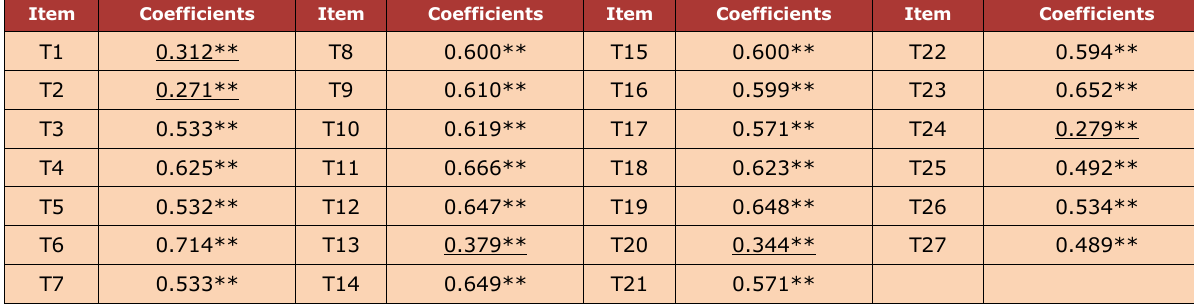
Table 1. Correlation coefficients between item and the total points of the